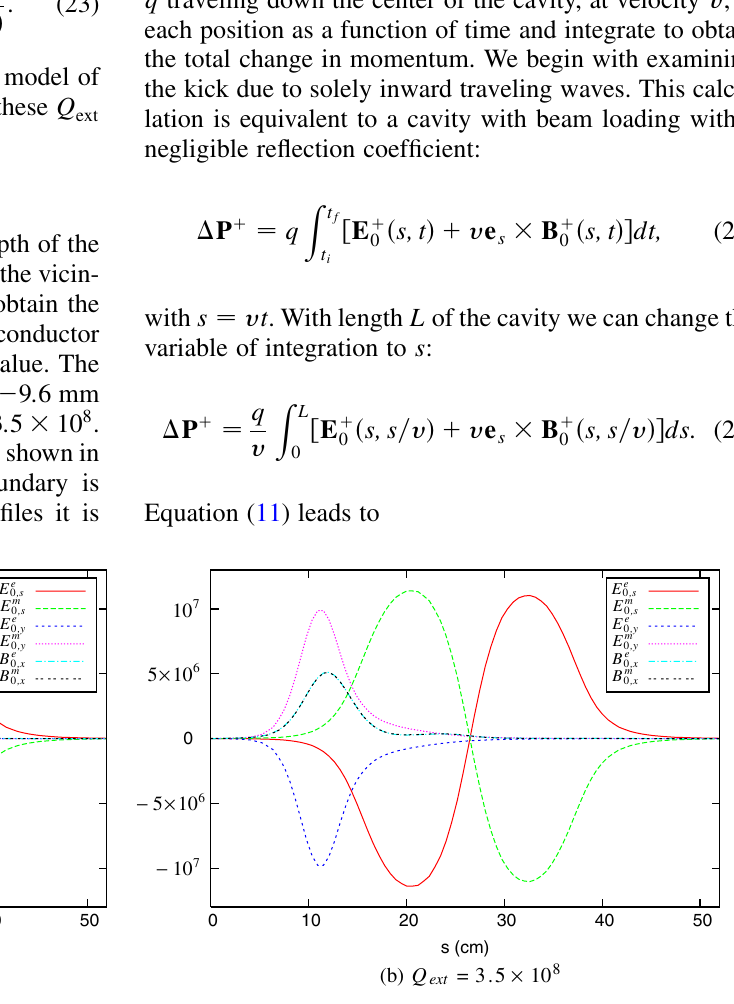
values of 7 (cid:9) 10 7 and 3 : 5 (cid:9) 10 8 . Units are MV = m and T for the electric ext and E m are scaled by 10 3 and B e and B m are scaled by 10 9 . The standing wave approximation 0 ;y 0 ;y 0 ;x 0 ;x (cid:8) (cid:1) E e (cid:8) B e and B m 0 0 0 0